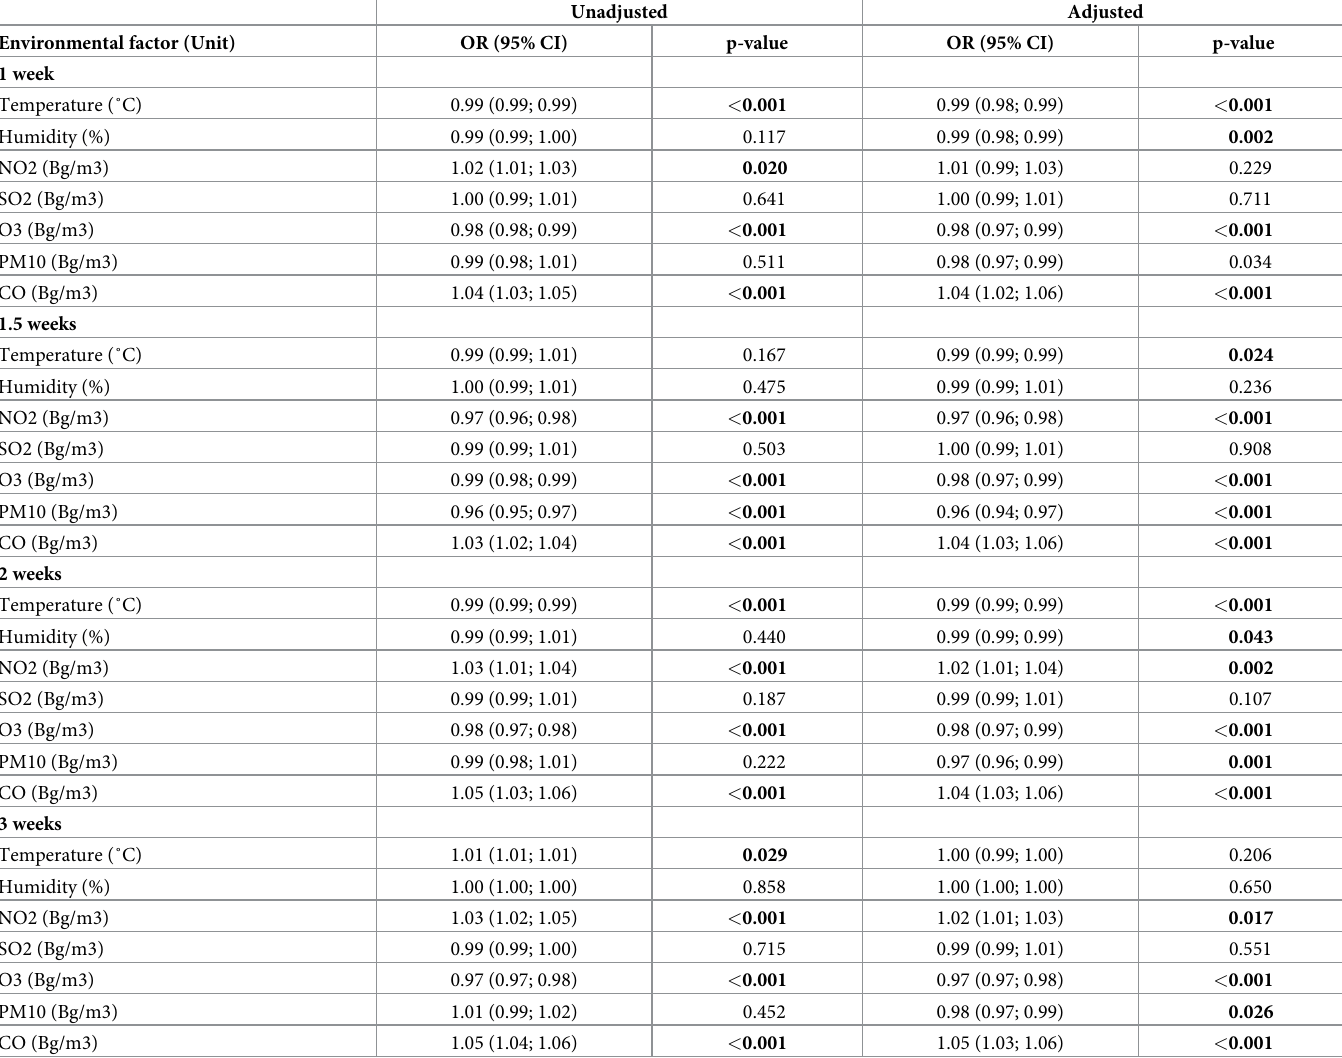
Table 2. Bivarite and multivariable models results for the associations between environmental factors and COPD exacerbation hospital admissions for study time periods (1, 1.5, 2 and 3 weeks before hospitalization).